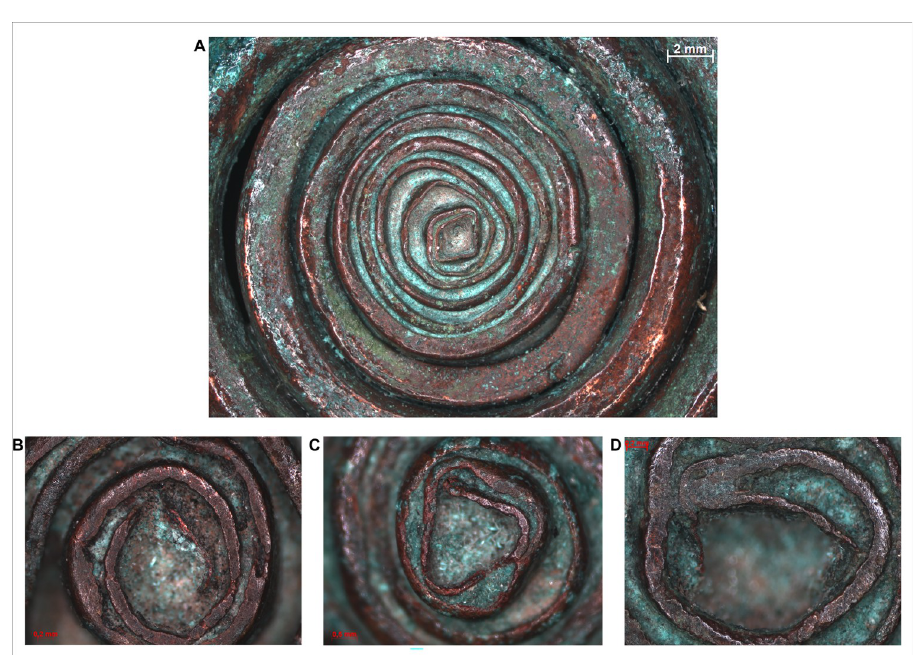
Fig 14. Micrographs showing the macrostructure of the spectacle spiral pendants. Photo: Eszter Horva´th. (A) Varying thickness and cross-section on the inner segment of the spiral coils on one of the spectacle spiral pendants (O˝.2019.8.1.183.). (B–D) Inner segments of the spiral coils with oblong cross-section (B-C. O˝.2019.8.1.182., D. O˝.2019.8.1.183).